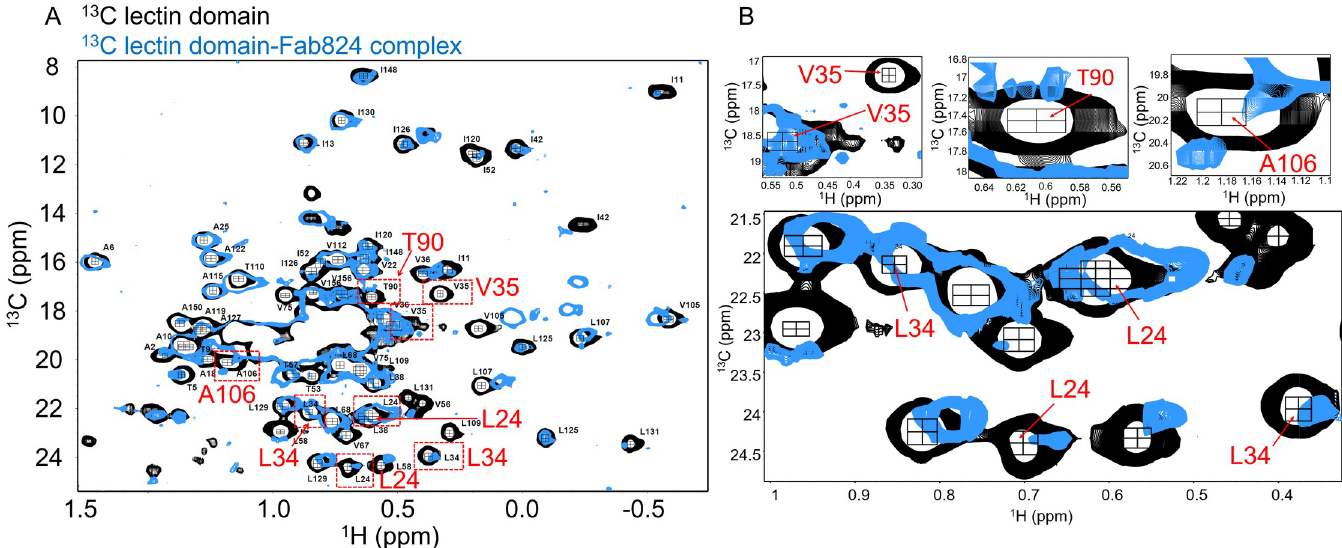
Fig 3. 13 C-methyl TROSY HMQC spectra showing perturbations in the lectin domain due to Fab824 binding. The spectrum of free LD is shown in black and the lectin domain in complex with Fab824 is shown in blue. The peaks are not fully filled in to provide clarity. Examples of the largest perturbations are highlighted in red boxes. Note that each methyl group of a sidechain gives its own peak (i.e., two peaks/residue for Ile, Leu, Val). (B) Expanded regions of the NMR spectra showing examples of residues with large perturbations.